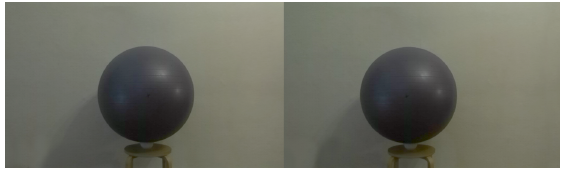
Figure 6. Left and right image of the sphere.